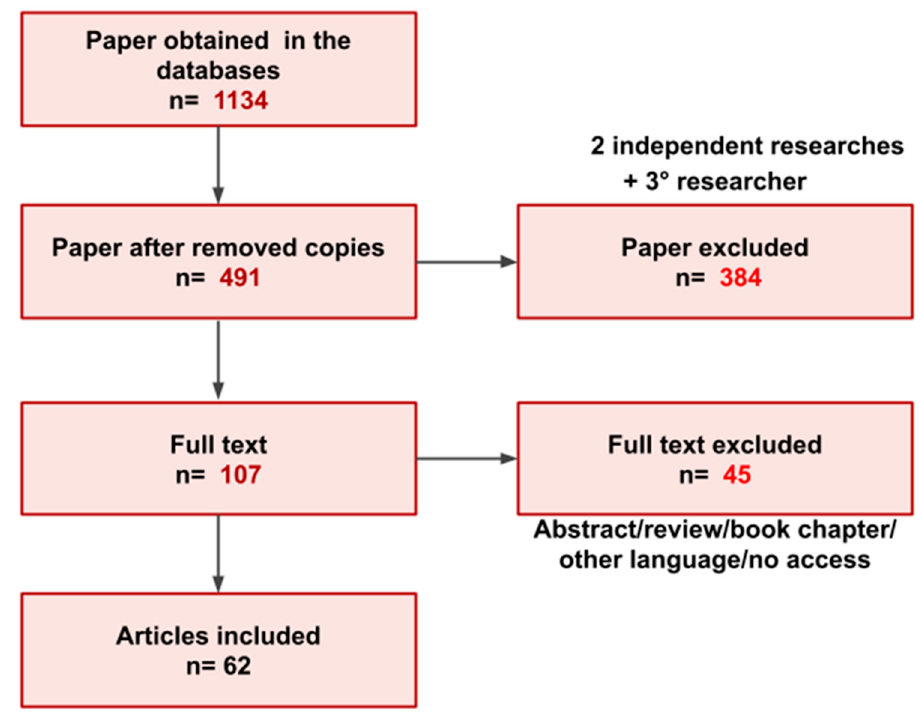
Figure 1. Overview of the paper selection process for inclusion in the present review.